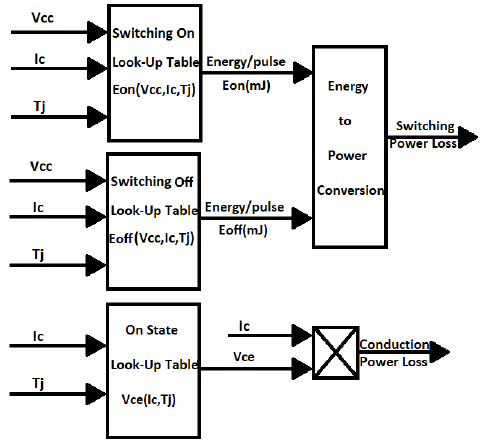
Figure 11. IGBT power losses calculation using look-up tables.